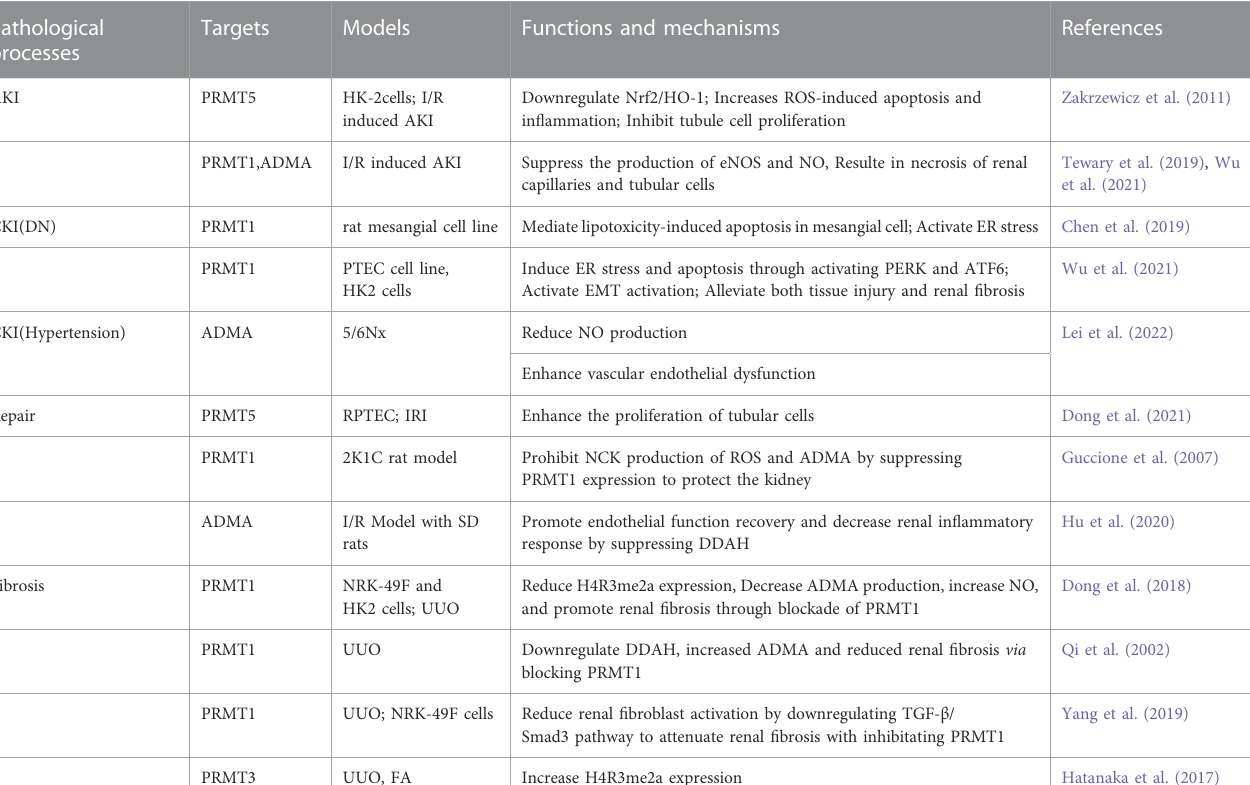
TABLE 3 The role of PRMTs in renal injury, repair and fi